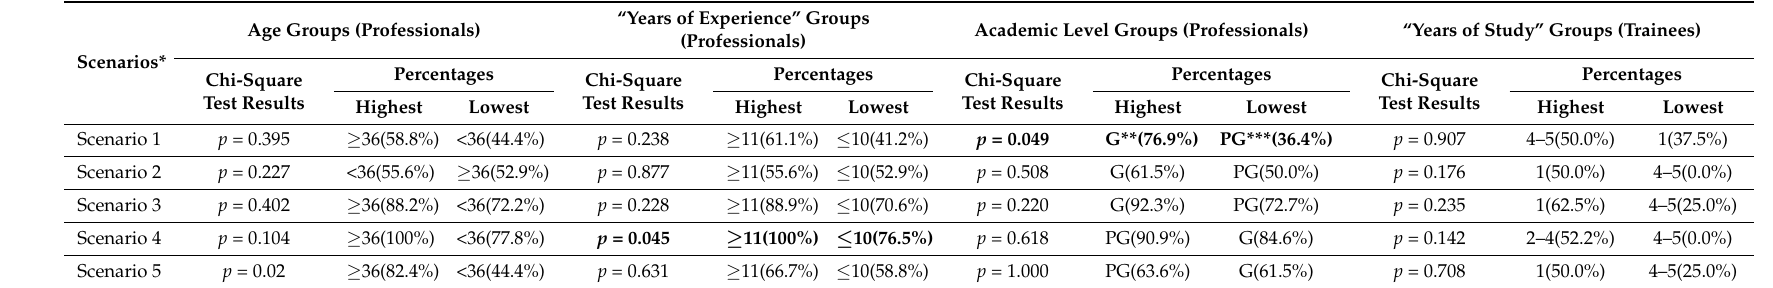
Table A4. Within groups differences—risk behaviours (significant results in